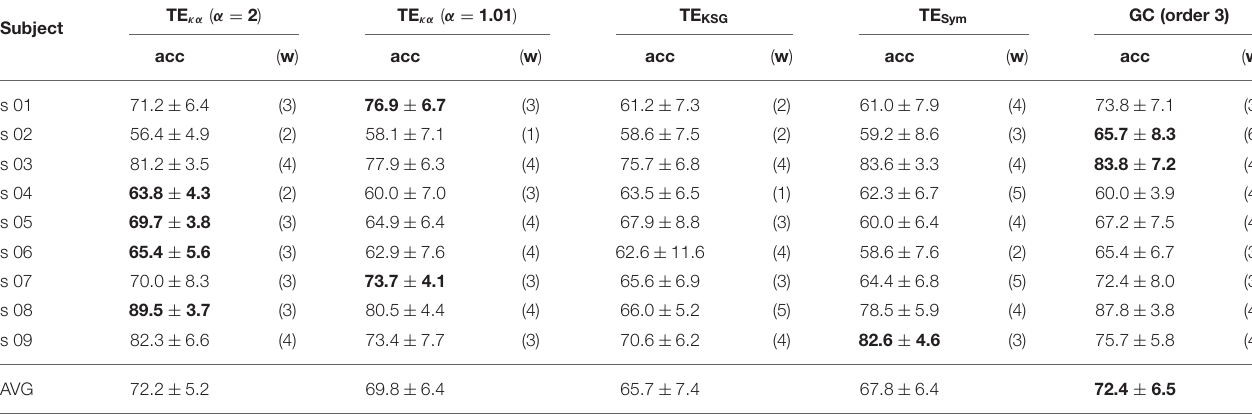
The bold values indicate the highest accuracies obtained for each subject.